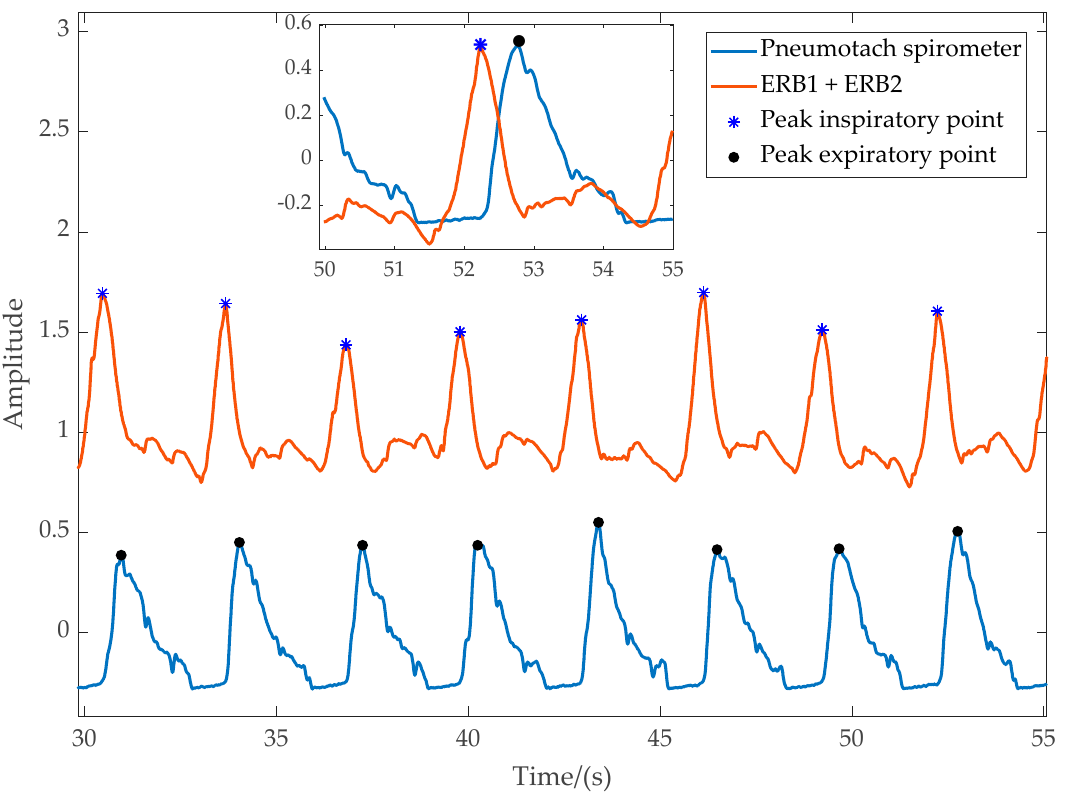
Figure 4. Data captured from the pneumotach spirometer flow and VitalCore. Inset: overlapped data excerpt.